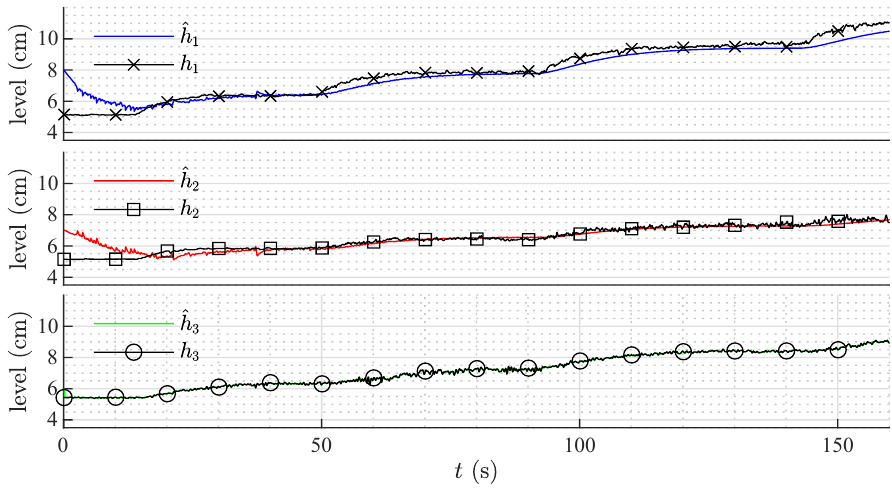
Figure 14. Extended Kalman Filter performance: 30% variation in all constant